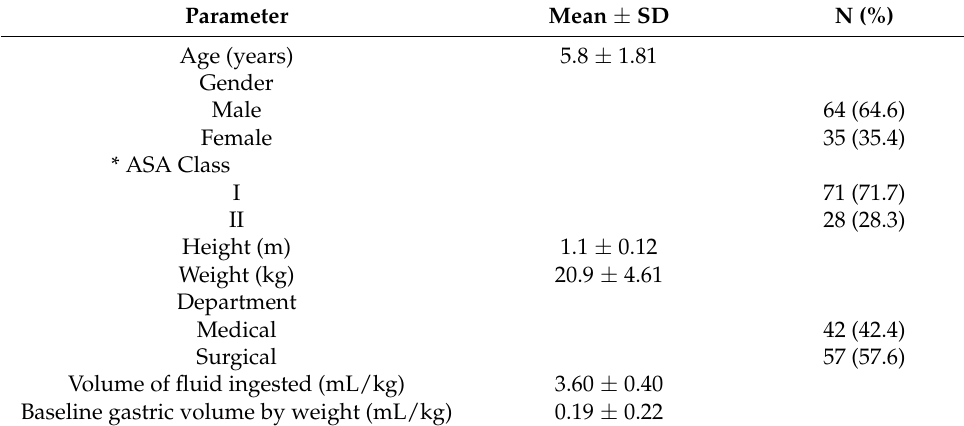
Table 1. Demographic characteristics of the study population.